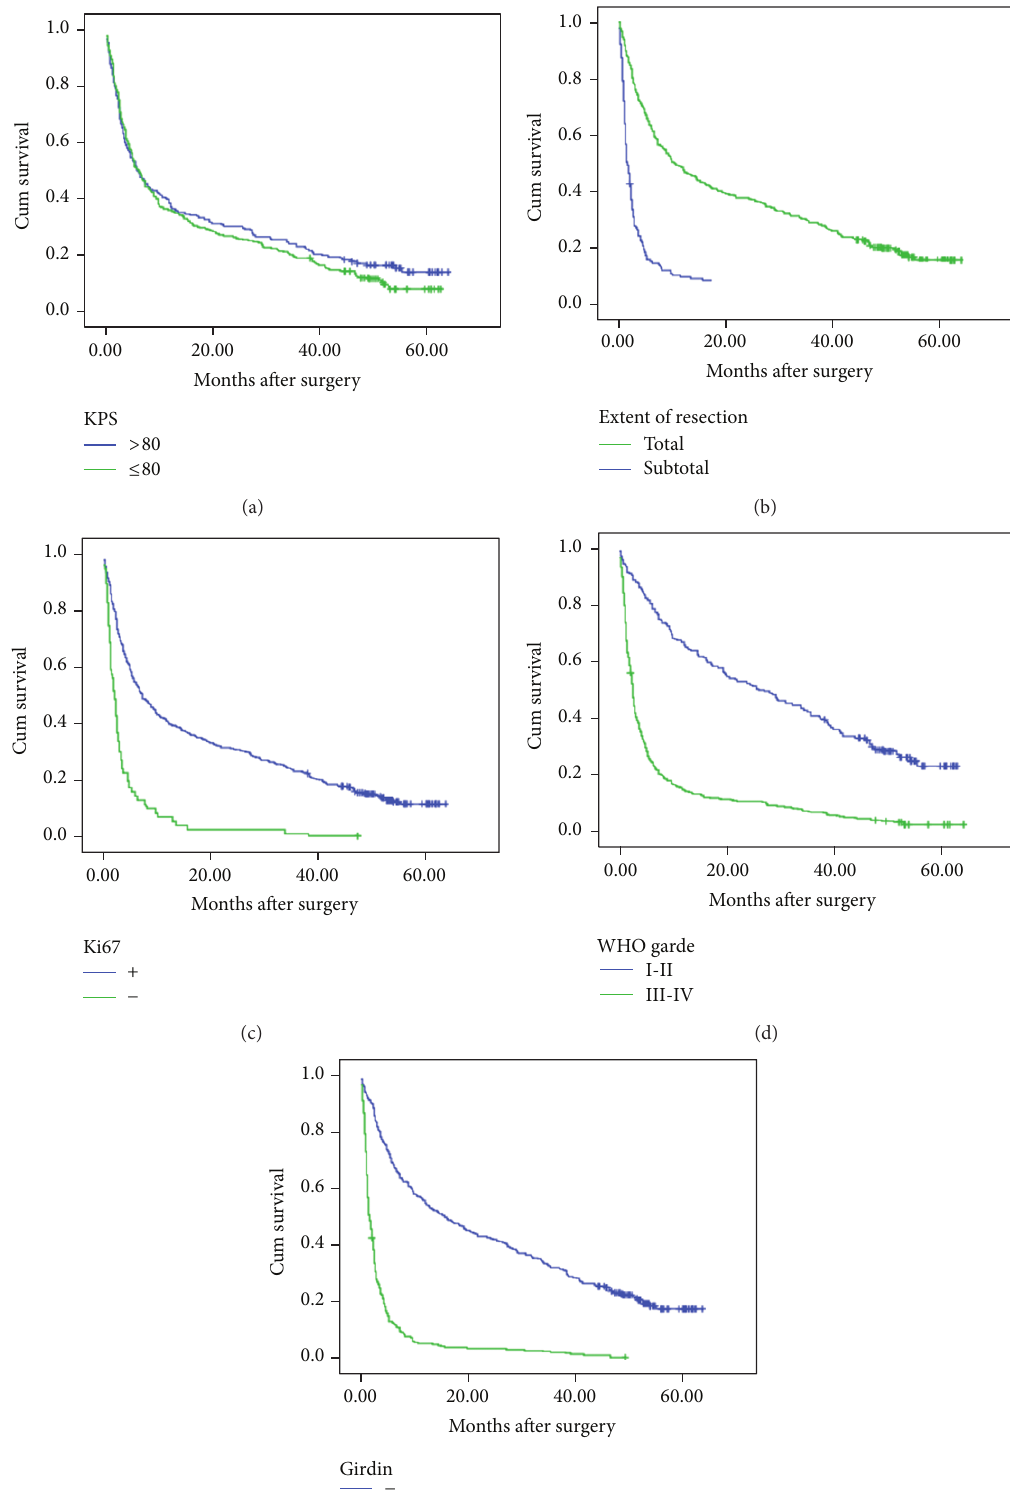
Figure 4: The survival analysis showed that KPS score (a), extent of resection (b), Ki67 (c), WHO grade (d), and Girdin (e) were observed to be independent prognostic factors ( 𝑃 = 0.044 , 0.010, 0.002, 0.001, and 0.001,